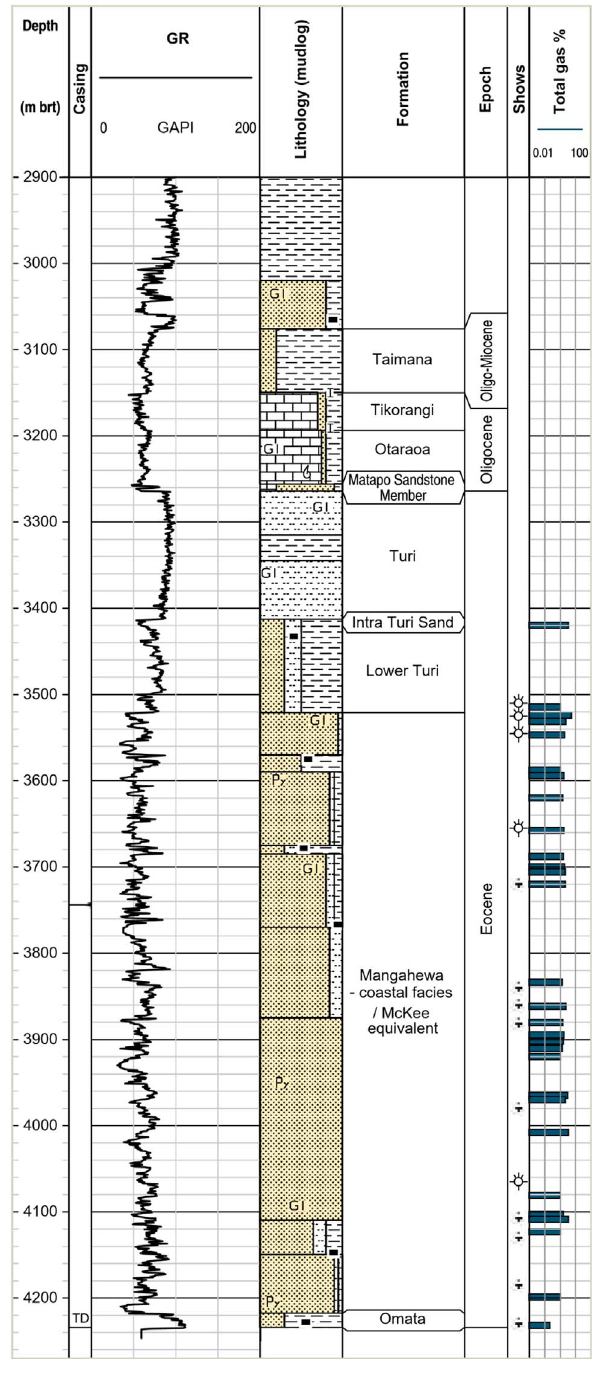
Figure 3. Pohokura-1 gas